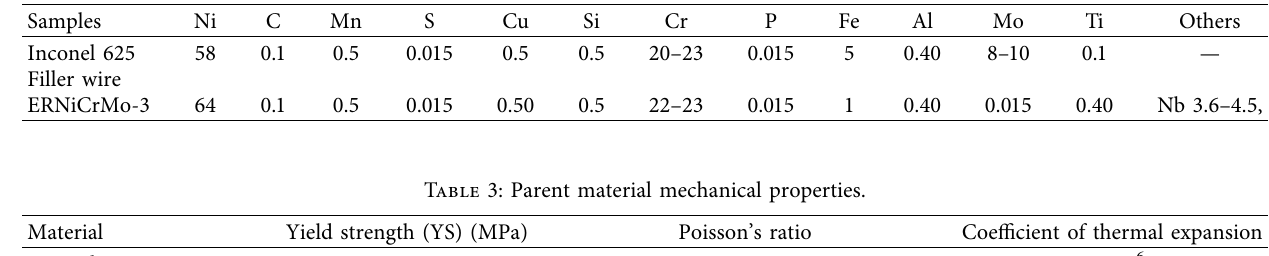
Figure 5: Multi-pass welding process. Table 2: Base plate and filler material chemical properties (wt %).